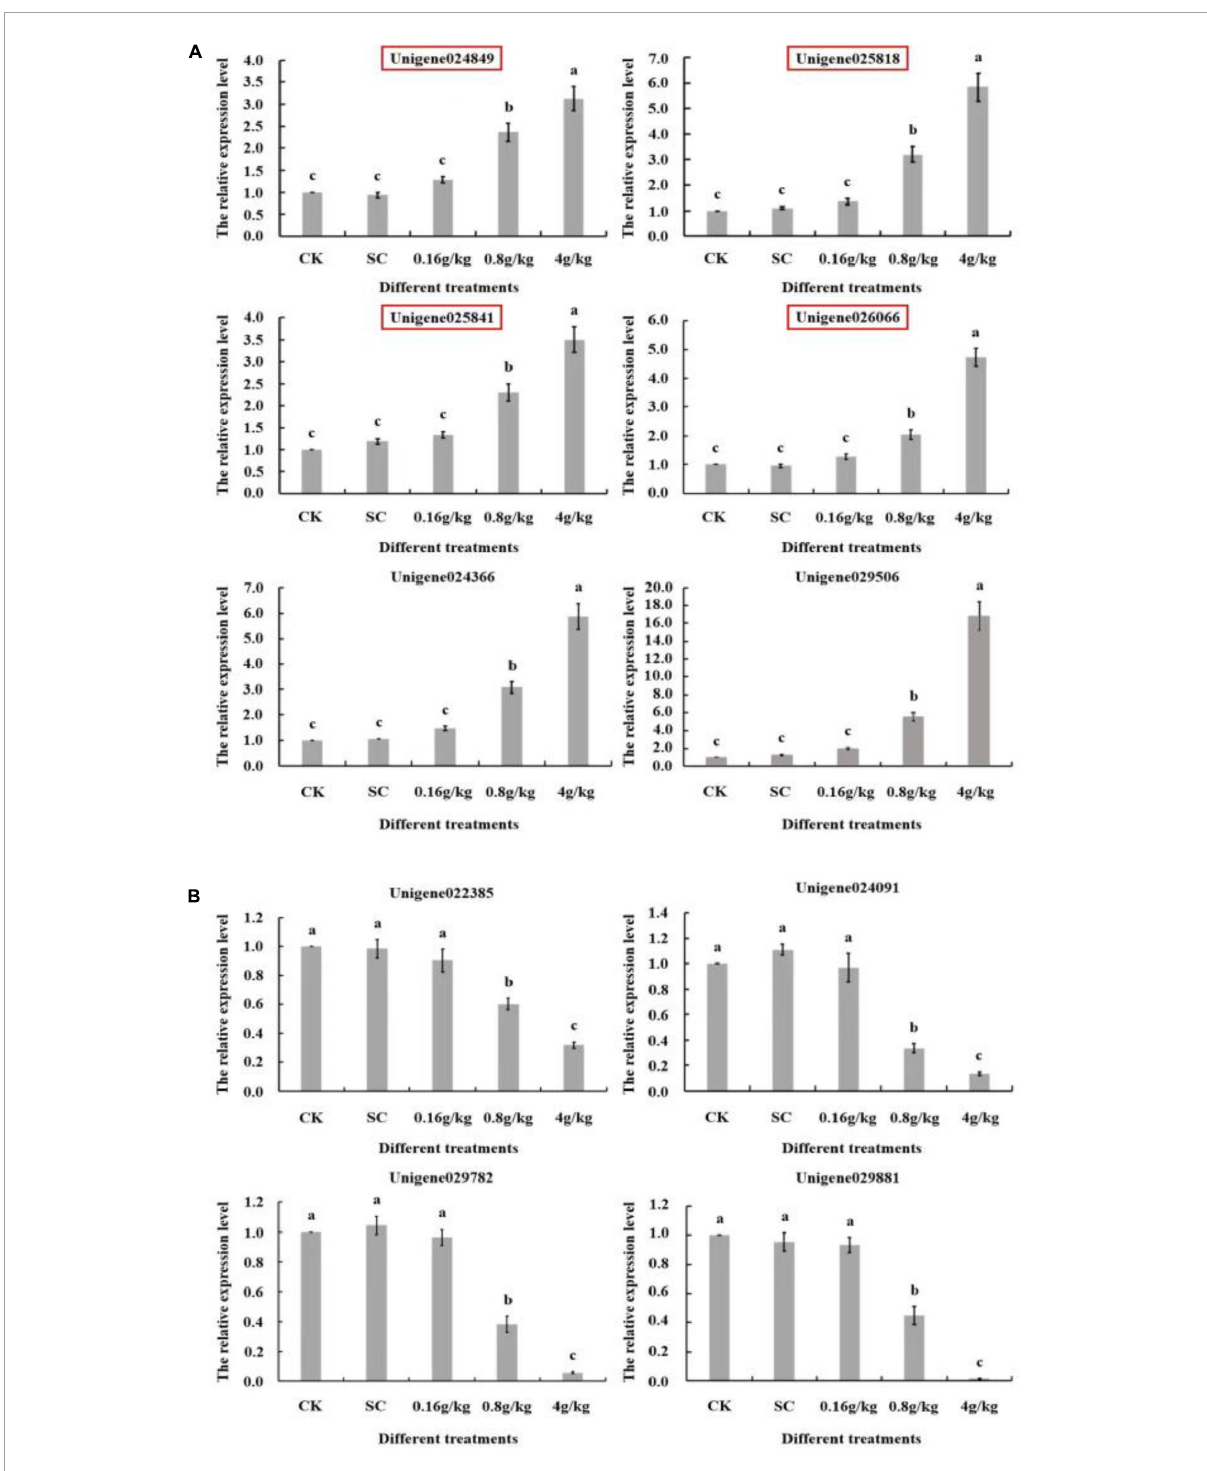
FIGURE3 The relative expression of the identified random ten unigenes explored by differential RNA-seq in S. exigua larvae after E β F treatments at different doses. (A) The relative expression of six upregulated unigenes in S. exigua after E β F treatments at different doses. (B) The relative expression of four downregulated unigenes in S. exigua after E β F treatments at different doses. CK (blank control) and SC (solvent control) were set as controls. The concentrations of E β F treatments were set as 0.16, 0.8, and 4 g/kg; the units of g/kg in all treatment groups mean the mass ratio of E β F/artificial diet. Different lower-case letters indicated a significant difference determined by performing ANOVA, followed by Tukey’s HSD test ( p <